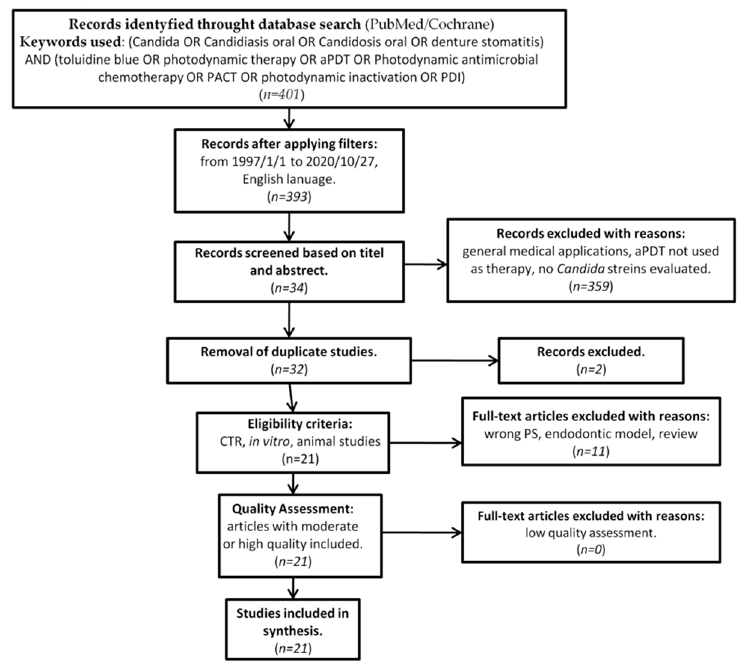
Figure 2. PRISMA flow ‐ chat of selected criteria for the included article reports.